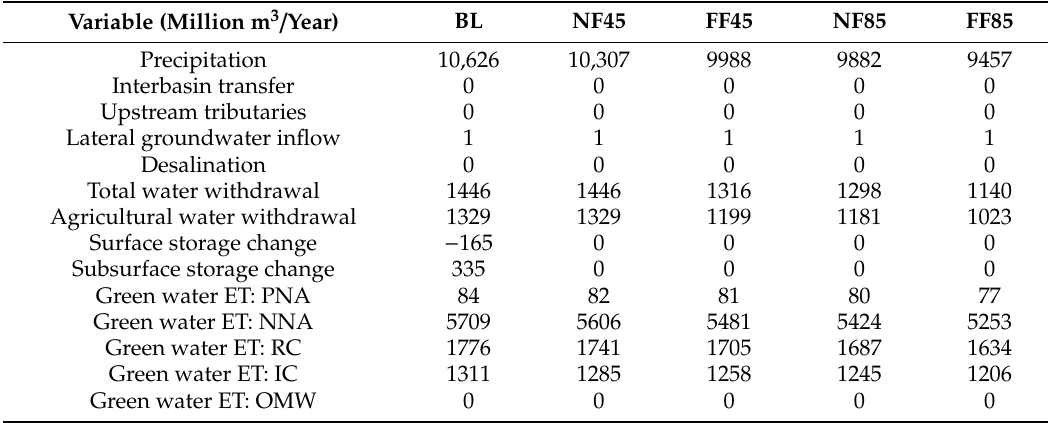
Table A3. Resource base sheet of the Jucar river basin,